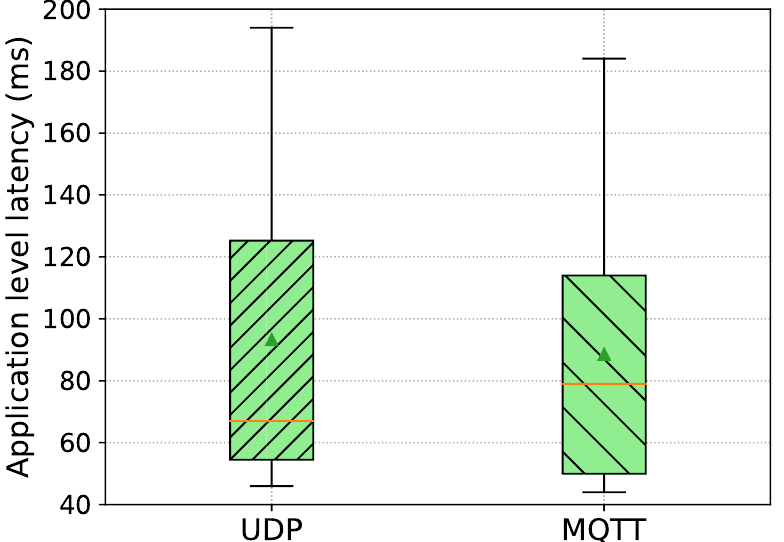
Figure 9. Application-level latency from the Traffic Management System (TMS) to the OBUs con- nected to the same edge cloud. OBU 1 receives DENM messages over UDP and OBU 2 receives over